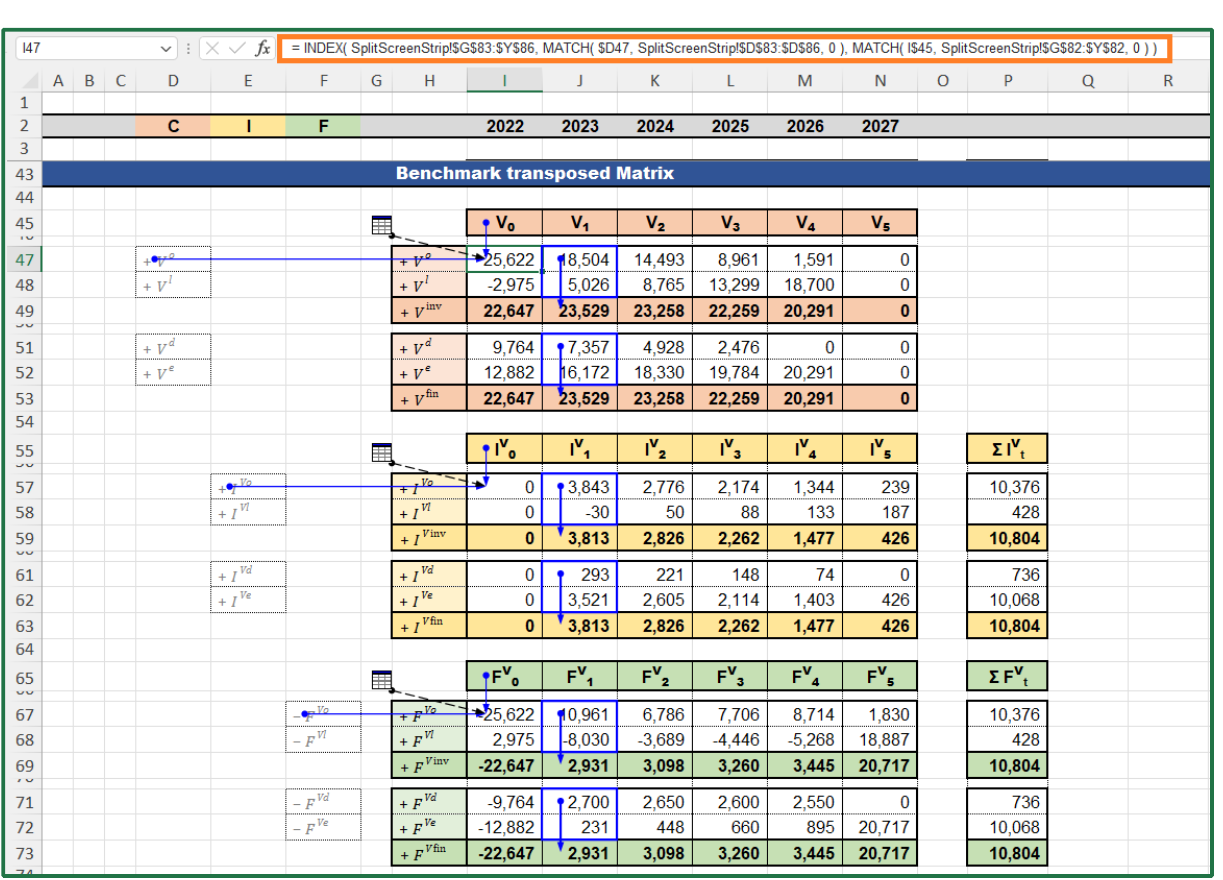
Figure 46. Benchmark Transposed Matrix. Cell I47 contains the formula for picking up the economic value of operating assets 𝑉 (cid:3042) as of period 𝑡 = 0 (“TransMatrix” sheet).